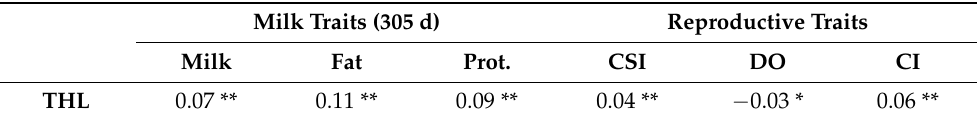
Table 2. Phenotypic correlation between true herd life and milk and reproductive traits of Holstein Frisian cows in Tunisia. Milk Traits (305 d) Reproductive Traits Milk Fat Prot. CSI DO CI THL 0.07 ** 0.11 ** 0.09 ** 0.04 ** − 0.03 * 0.06